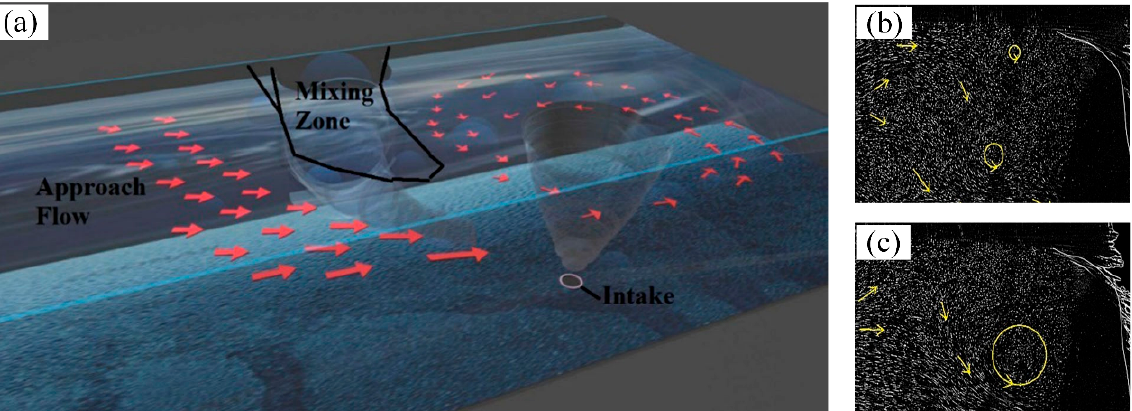
Figure 10. The evolution process of local vortices. ( a ) Diagram of vortexes, mixed zones, and closer flows. ( b ) Instantaneous streak line at t = 4 s. ( c ) Instantaneous streak line at t = 8 s. (Reprinted with permission from Ref. [82]. 2019, Springer Nature).